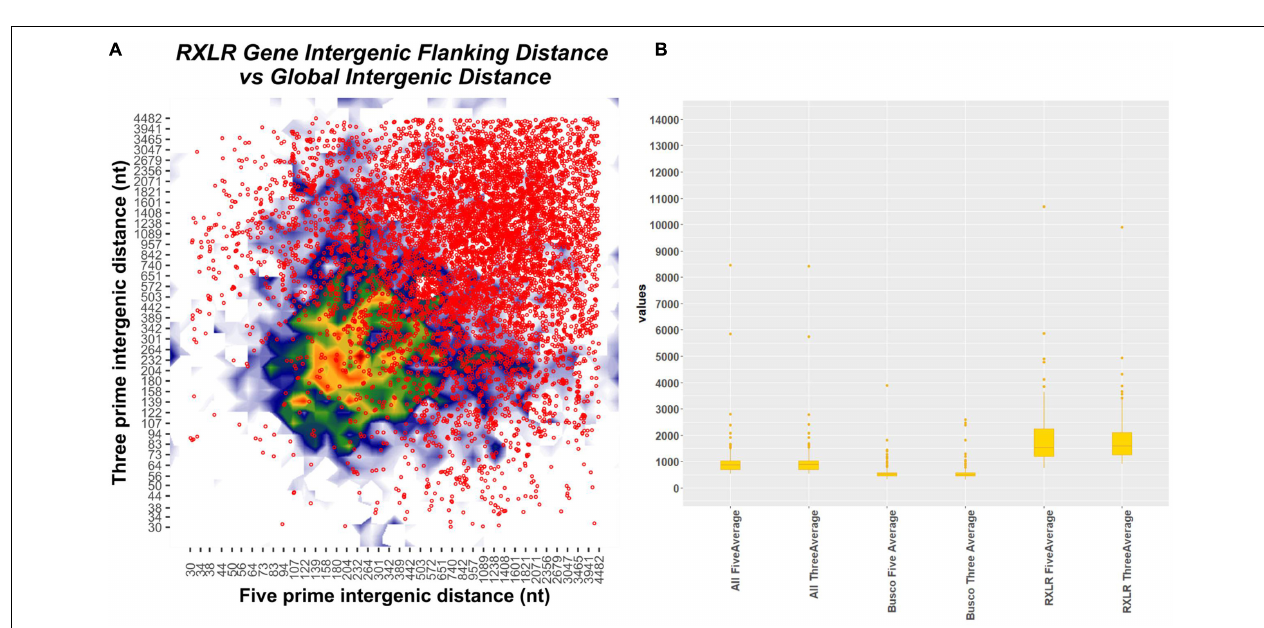
FIGURE 5 | Plot showing flanking intergenic distances of different categories of genes of all the 128 Phytophthora species concatenated together. (A) Contour plot depicting the five prime and three prime intergenic distances plotted in x- and y-axis. The scatter plot on the top of the contour plot in red dots depicts the position of the RxLR effectors overlaid on the contour plot. There is a clear indication that the RxLRs have significantly large intergenic distances than the other genes. (B) Box plot of intergenic distances (both 5 (cid:48) and 3 (cid:48) regions) of all the genes concatenated together with BUSCO genes and RxLR genes. The position and the median point of the boxes are indicators of higher 5 (cid:48) and 3 (cid:48) distances seen in all the Phytophthora genomes.